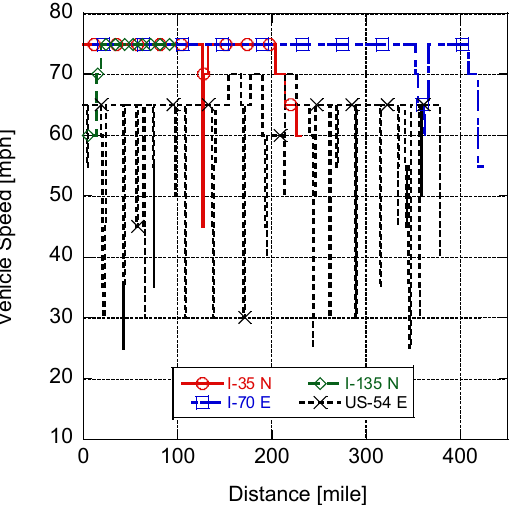
Figure 1. Vehicle speed as a function of distance for the simulated roads.